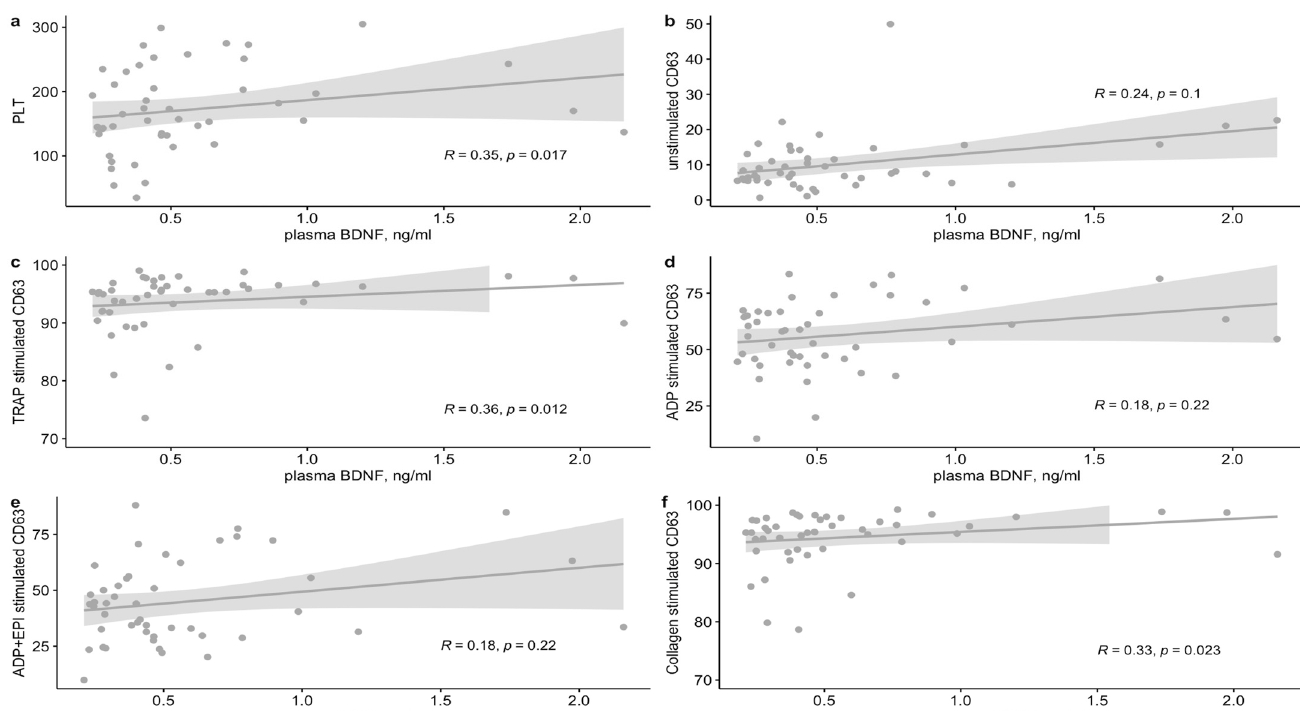
Figure 2. Correlation of plasma BDNF levels with ( a ) platelet count, ( b ) unstimulated platelet CD63 expression and ( c – f ) stimulated platelet CD63 expression. Scatter plots are shown, with a regression line and a 95% confidence interval. BDNF, brain-derived neurotrophic factor; PLT, platelet count, ×109/mL; TRAP, the protease-activated receptor (PAR)-1 agonist thrombin receptor activator peptide; ADP, Adenosine diphosphate; EPI, epinephrine.